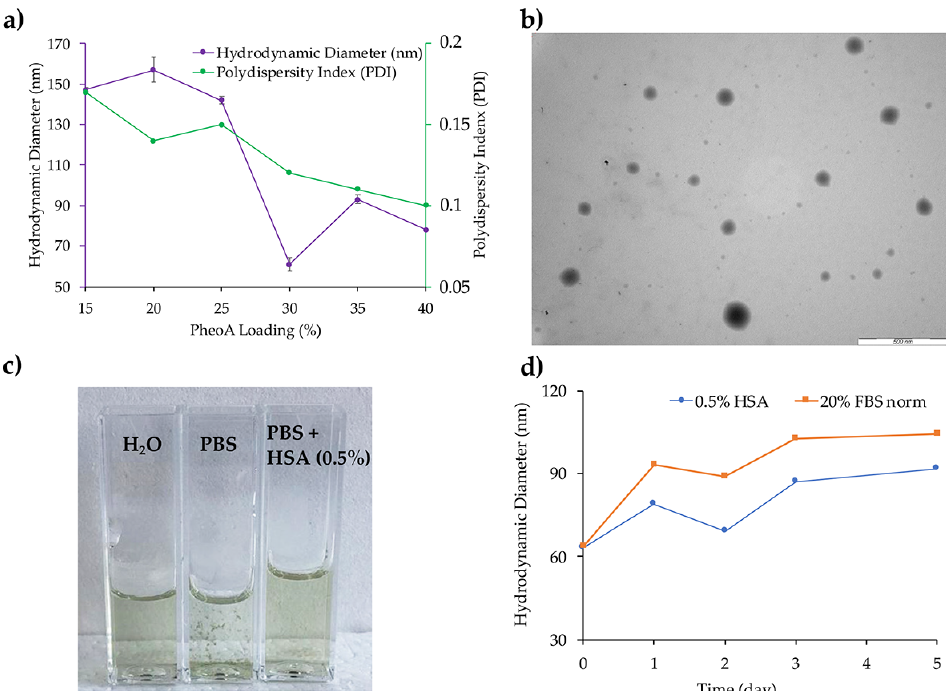
Figure 2. ( a ) PheoA ≅ PTX 2 S optimization as a function of PheoA loading; ( b ) TEM analysis of PheoA ≅ PTX 2 S (scale bar 500 nm; ( c ) Comparison between PheoA ≅ PTX 2 S solution in water, PBS and PBS + 0.5% HSA; ( d ) PheoA ≅ PTX 2 S stability trend in PBS + 0.5% HSA and PBS + 20% FBS.